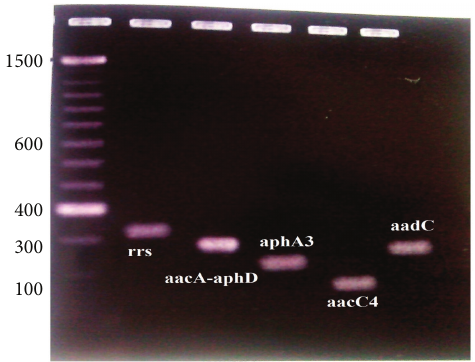
Figure 1: Gel documentation for genes encoding aminoglycoside modifying enzymes.